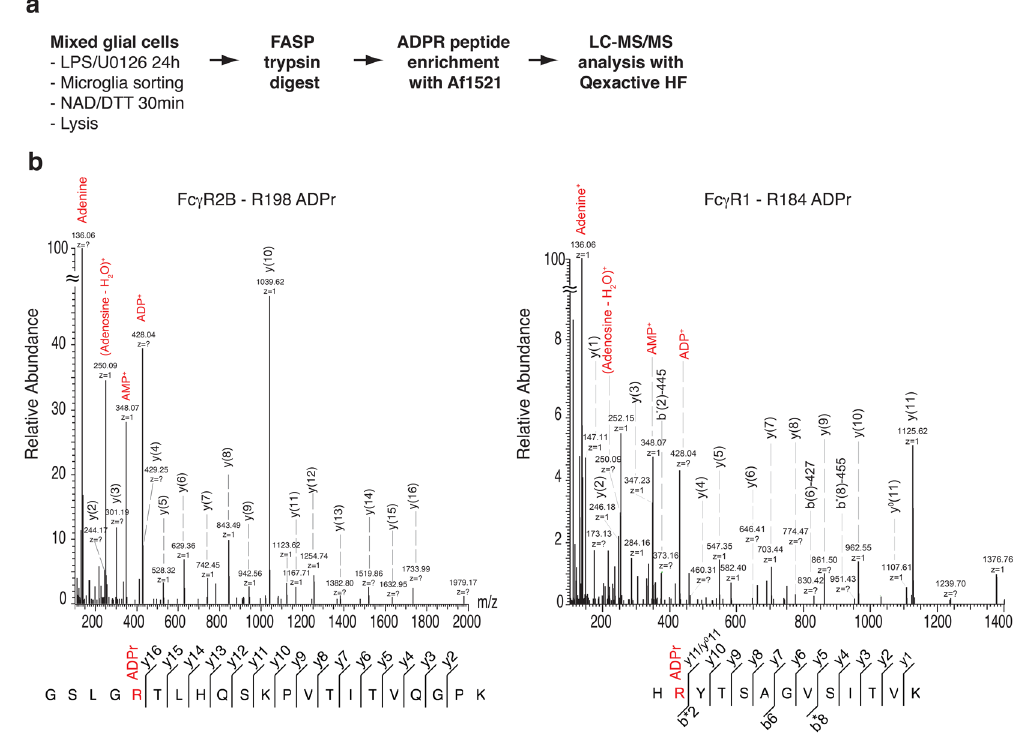
Figure 4. MS/MS analyses of ADP-ribosylated peptides fragmented using HCD. ( a) Experimental setup for the identification of ARTC2.1 target proteins in microglia. (b) The presented peptides belong to Fc γ R2B, which is ADP-ribosylated at R198 (left) and Fc γ R1, which is ADP-ribosylated at R184 (right). The ADP-ribose specific fragment is indicated in the spectrum in red and peptide sequence coverage is shown below the respective